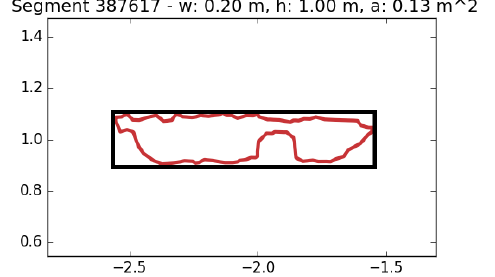
Figure 5: two-dimensional visualization of a beam segment; red: α -shape, black: minimum bounding rectangle